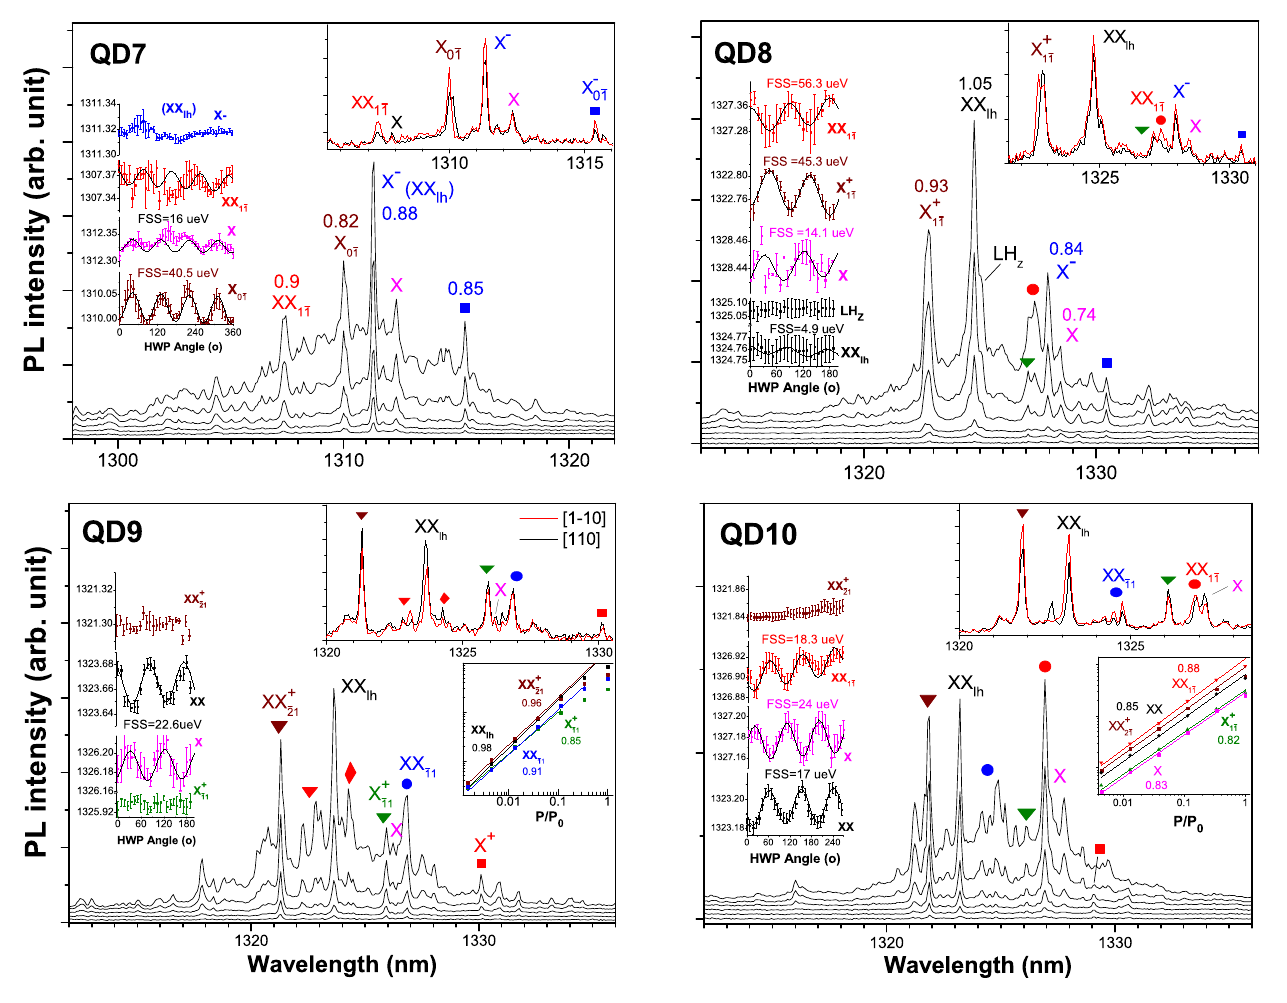
Figure 4. Pump-power-dependent μ PL spectra of QD7–10 with LH excitons in small FSS. Inverted triangles: XX 21+ (wine), X ī 1+ (green), circles: XX 1 ī (red), XX ī 1 (blue), squares: X + (red), X 0 ī − (blue), pink: X, black: XX lh , red diamond in QD9: higher excitons. ( Insets: left ): FSS oscillations; ( top-right ): polarization-resolved spectra; ( bottom-right ): pump-power dependence, slope marked in plot or near peak.